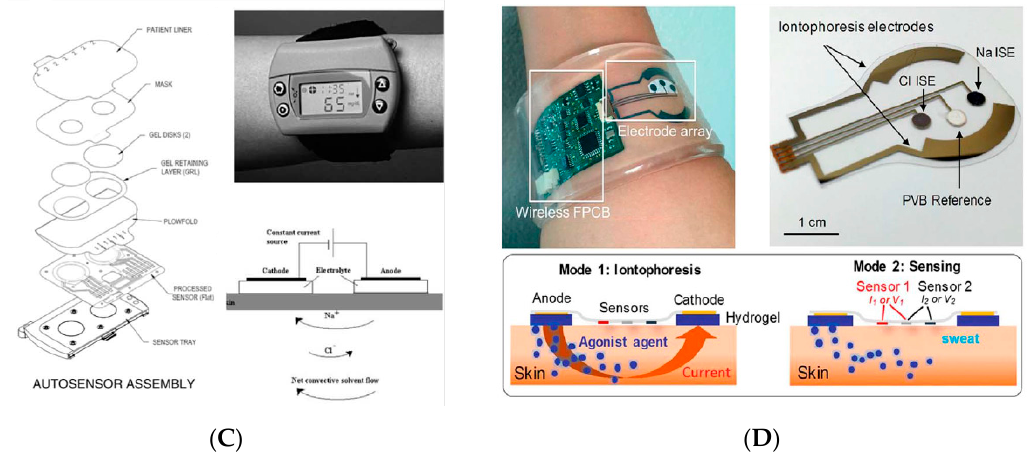
Figure 8. ( A ) Depiction of two different wearable epidermal glucose sensors using the interstitial fluid (ISF) or sweat. ( B ) Basic functioning of the enzymatic amperometric glucose sensor. Reproduced from [35] with permission. © 2017 Elsevier B.V. All rights reserved. ( C ) Glucose sensing in ISF through reverse iontophoresis (bottom-right) and GlucoWatch® biographer display. Reproduced from [36]